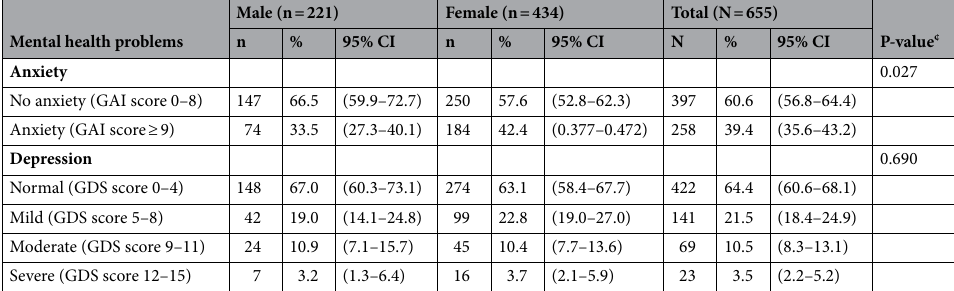
Table 2. Prevalences of anxiety and depression among the study participants by gender (N = 655). P-value ¢ : P-value of the chi-square test between males and females. GAI Geriatric Anxiety Inventory, GDS Geriatric Depression